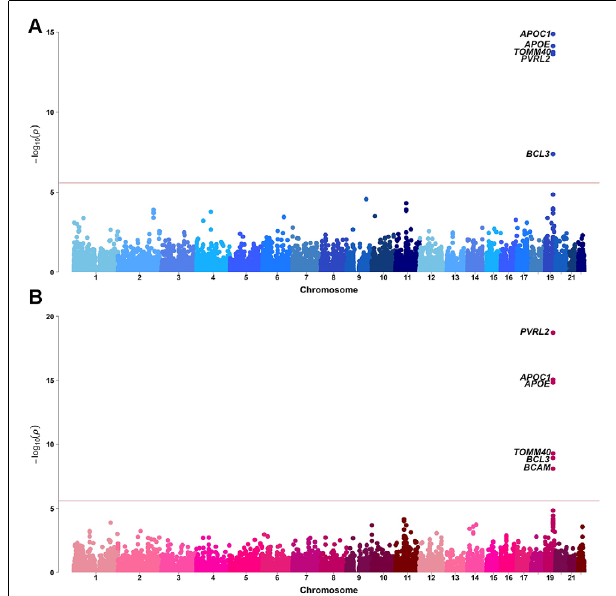
FIGURE 2 | Manhattan plots of MAGMA-annotated genes in Alzheimer’s disease genetics consortium (ADGC) combined phase 1 and phase 2 samples of (A) male and (B) female strata. The red line denotes the gene-based genome-wide significance level of P -value = 2.61 × 10 − 6